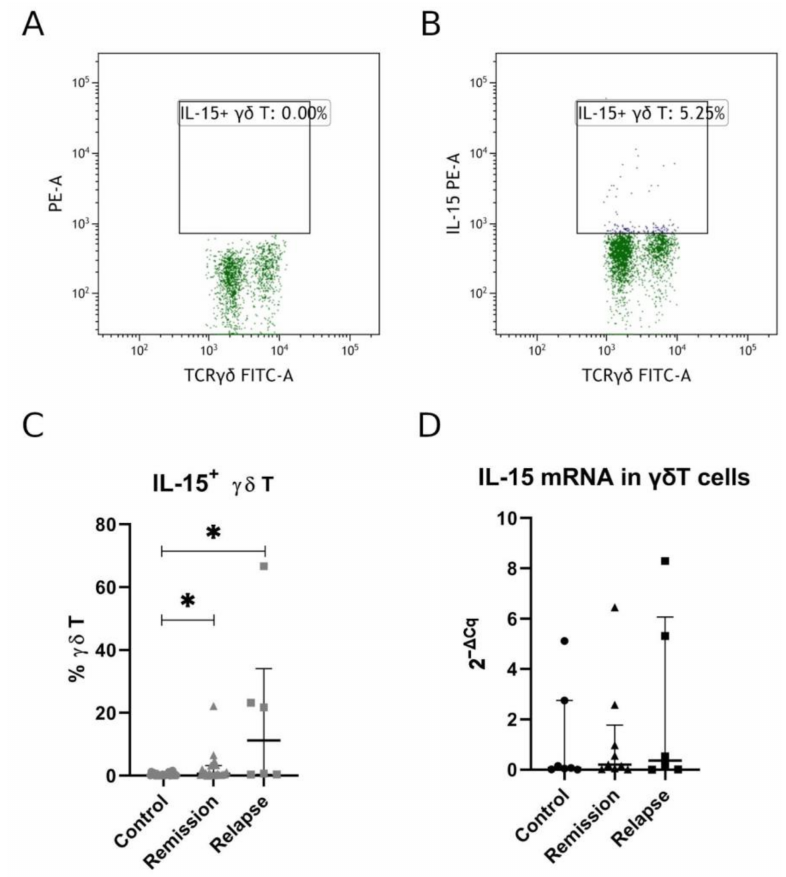
Figure 3. Percentage of IL-15+ γδ T cells in MS patients. Panel ( A ) shows FMO (fluorescence-minus- one) control, and panel ( B ) shows IL-15 staining. Full data set for IL-15 expression measured by flow cytometry is presented in panel( C ), and panel ( D ) shows relative mRNA expression measured by RT-qPCR. Each shape in panels C and D represents separate patient. Data presented as median, IQR. Statistically significant differences are marked with asterisks (*), relapse vs. control p = 0.0096, remission vs. control p = 0.0231 (panel ( C )).